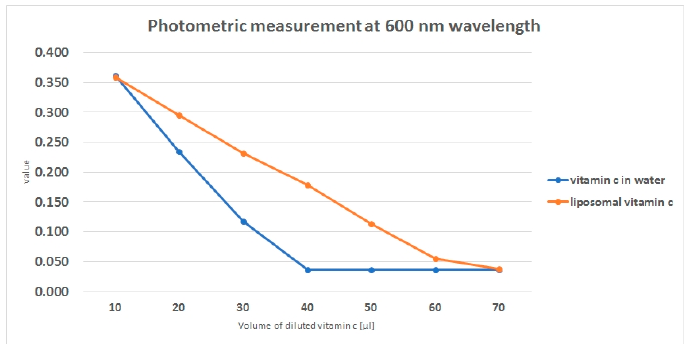
Figure 1. Photometric measurement of 2,6-dichloroindophenol sodium salt hydrate after adding different amounts of liposomal and non-liposomal vitamin C. Absorbance was measured at a wavelength of 600 nm.